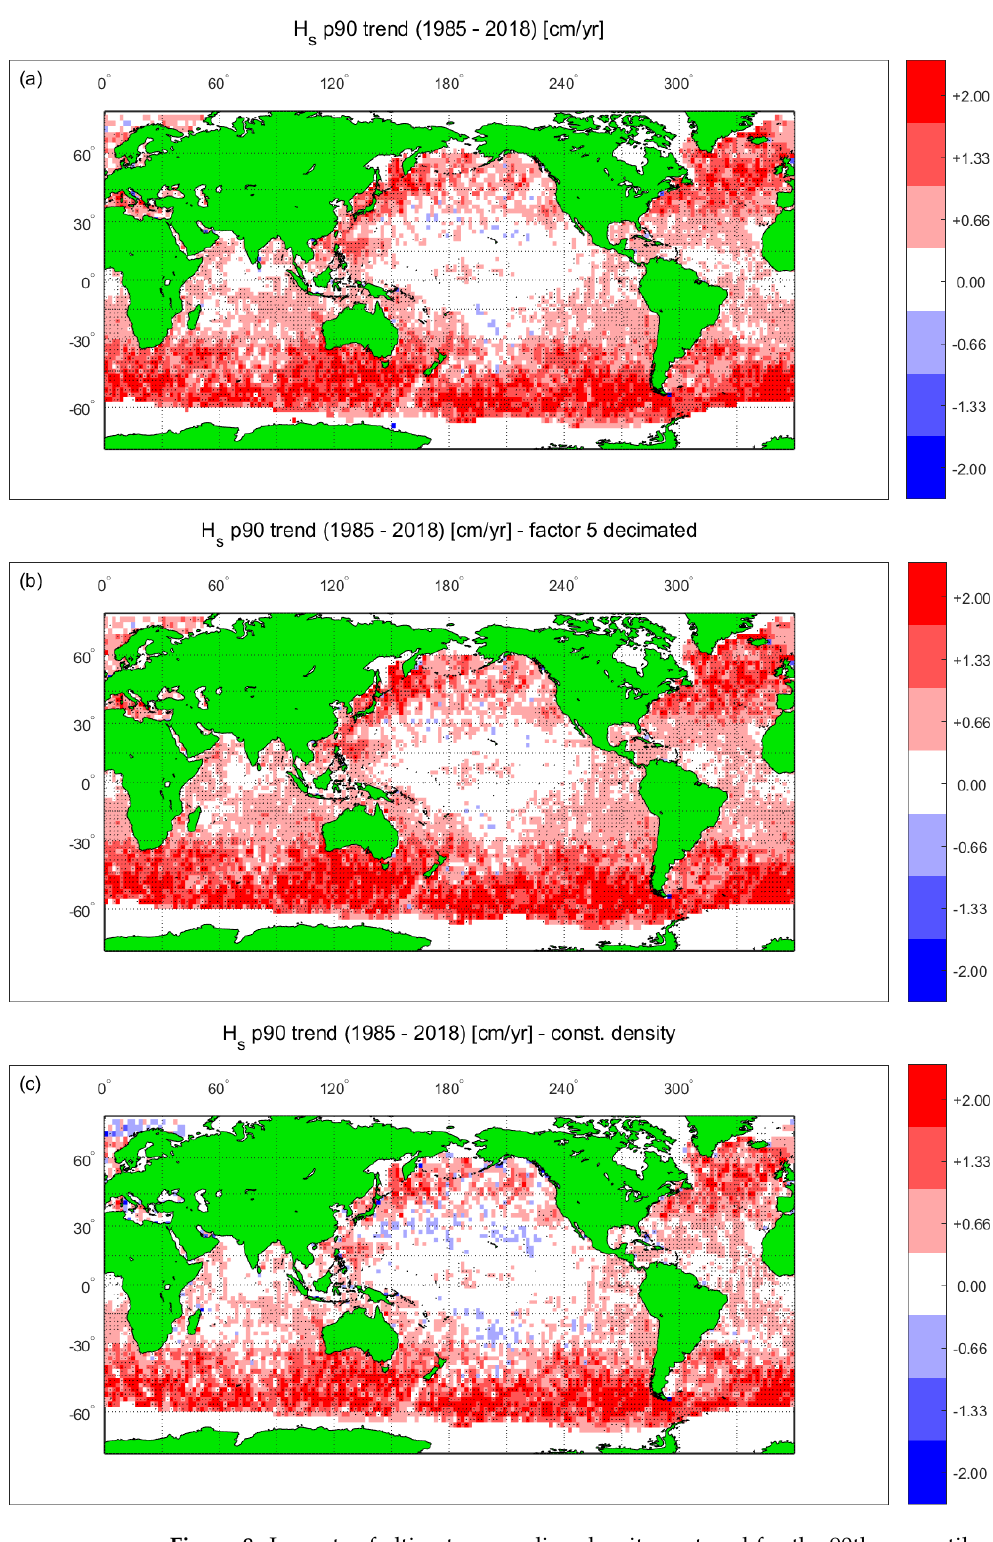
Figure 8. Impacts of altimeter sampling density on trend for the 90th percentile significant wave height. ( a ) All altimeter data used, ( b ) Data decimated by a factor of five, ( c ) More recent altimeter missions removed to yield approximately constant data density as a function of time. Values which are statistically significant at the 95th percent level are shown by small